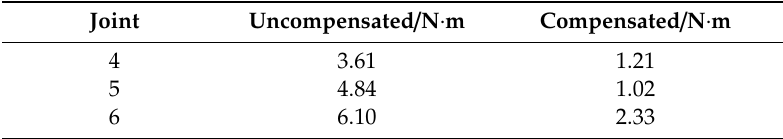
Table 2. RMS Error of Calculated Torque between Real